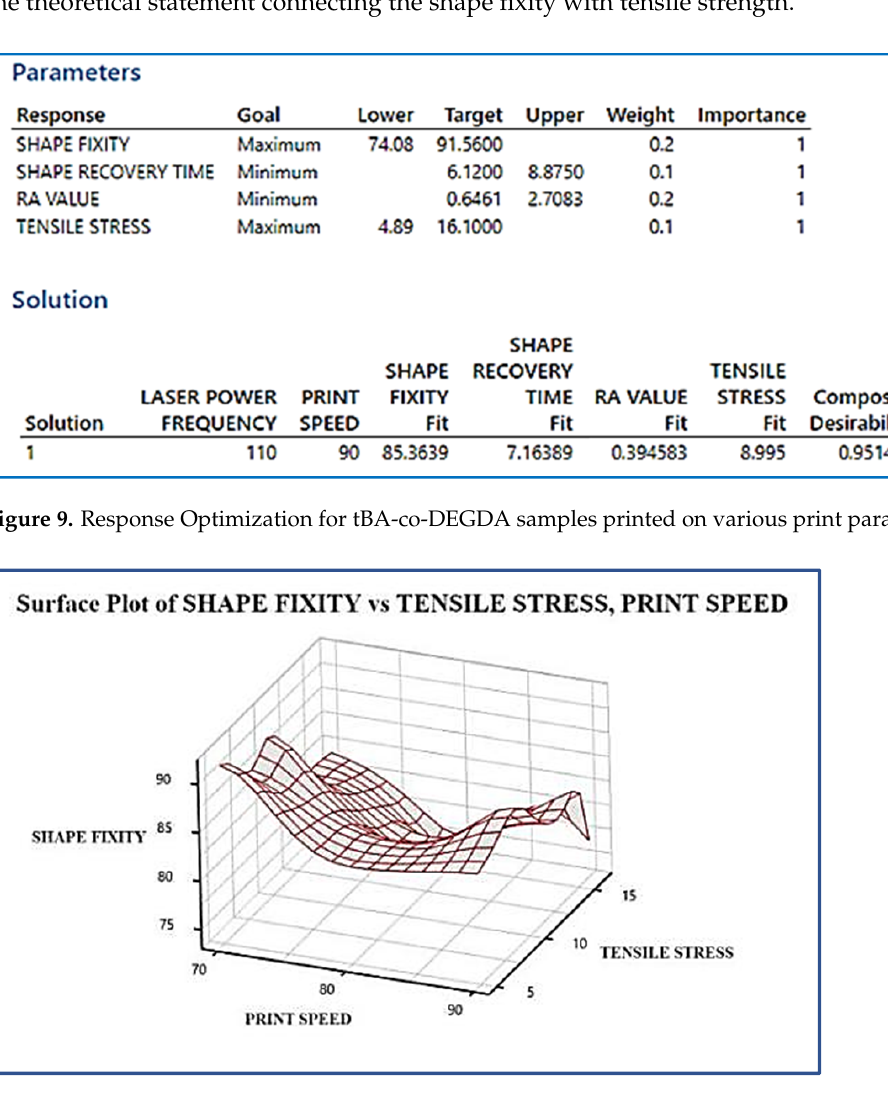
Figure 10. Variation of Shape fixity with changes in Tensile Stress and print